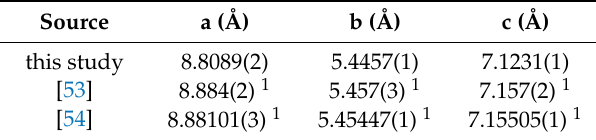
Table 1. Comparison of the cell parameters of the investigated baryte with previously published data.